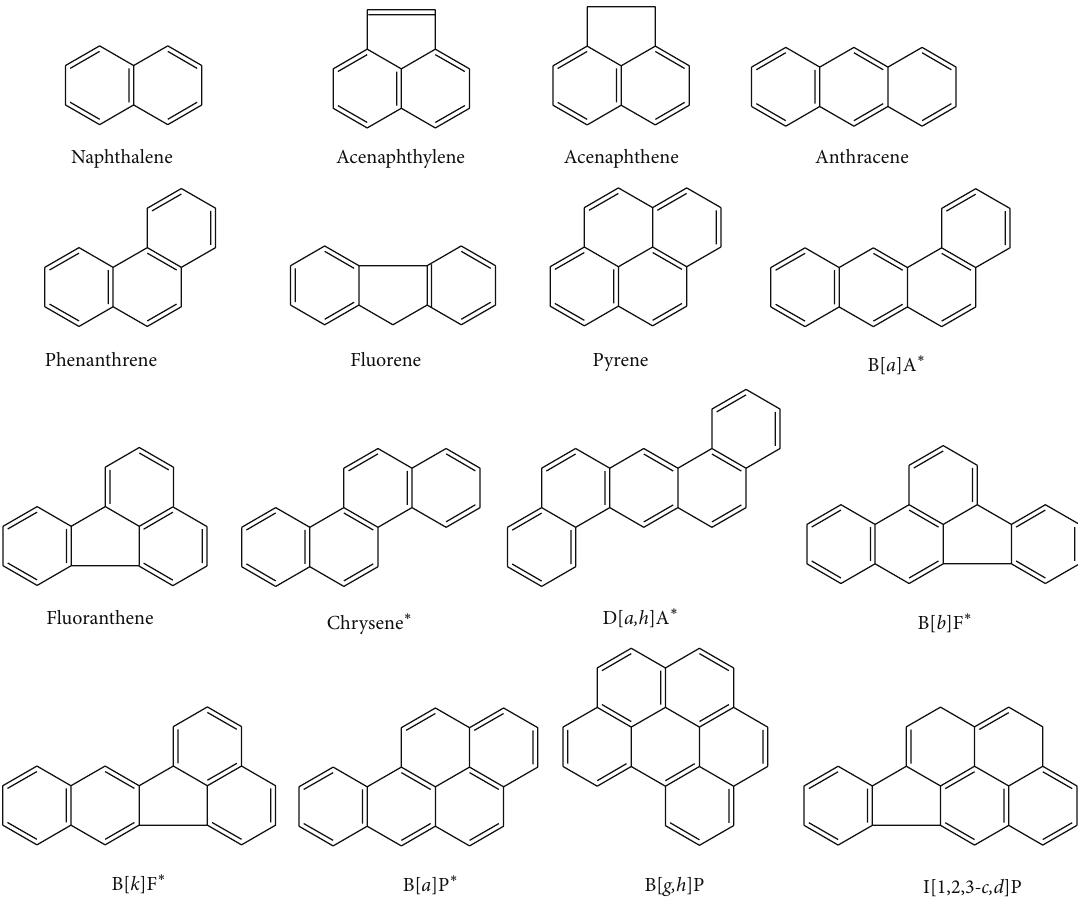
Figure 1: Chemical structures of the 16 United States Environmental Protection Agency (USEPA) priority PAH compounds. ∗ Non- threshold indicator compounds, also known to possess some genotoxic carcinogenic potential [8]. B[ a ]A: benzo[ a ]anthracene; D[ a , h ]A: dibenzo[ a , h ]anthracene; B[ b ]F: benzo[ b ]fluoranthene; B[ k ]F: benzo[ k ]fluoranthene; B[ a ]P: benzo[ a ]pyrene; B[ g , h ]P: benzo[ g , h , i